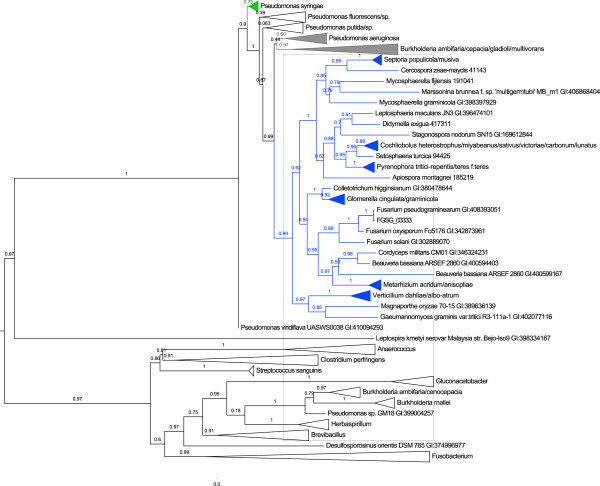
FGSG_03333 encodes a putative phosphorylcholine phosphatase with a shared selection process with bacterial plant pathogens. For protein FGSG_03333, a BLASTp search returns 231 hits with E-value < 1.0e-05 and these were merged with our results from the MycoCosm tree. A MUSCLE alignment [48] and maximum likelihood phylogenetic tree estimation by PhyML [49] returns this phylogenetic tree with branch support values, visualized by FigTree [50]. The tree indicates that this protein has been selectively retained in hemibiotrophic and necrotrophic fungal pathogens of cereals, plants and insects. Furthermore, this protein is closely related to a highly conserved protein in a large number of Pseudomonads, indicating a shared selection process and suggesting a common role in pathogenicity.